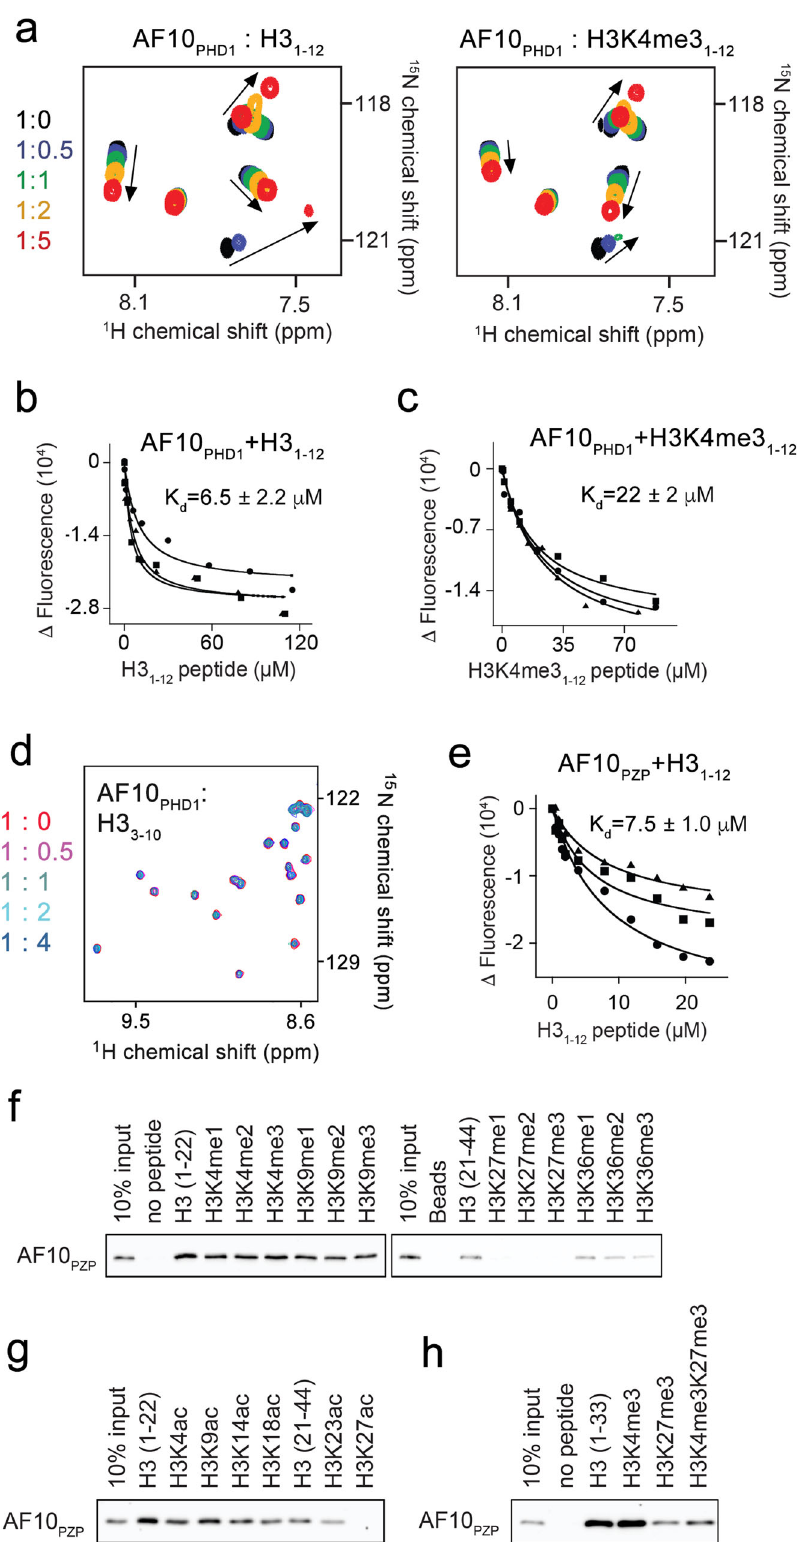
Fig. 3 AF10 PZP binds to the N-terminus of the H3 tail. a Overlay of 1 H, 15 N HSQC spectra of AF10 PHD1 in the presence of the increasing amount of H3 1-12 or H3K4me3 1-12 peptide. Spectra are colored according to the protein:peptide molar ratio. b , c Binding curves used to determine K d values by tryptophan + / − S.D. from three independent experiments ( n = 3). d Overlay of 1 H, 15 N HSQC spectra of AF10 fl uorescence. K d s are represented as mean values the presence of the increasing amount of H3 3-10 peptide. Spectra are colored according to the protein:peptide molar ratio. e Binding curves used to determine K d by tryptophan fl uorescence. K d is represented as mean + / − S.D. from three independent experiments ( n = 3). f – h Histone peptide pulldown assays of GST-AF10 PZP with the indicated biotinylated